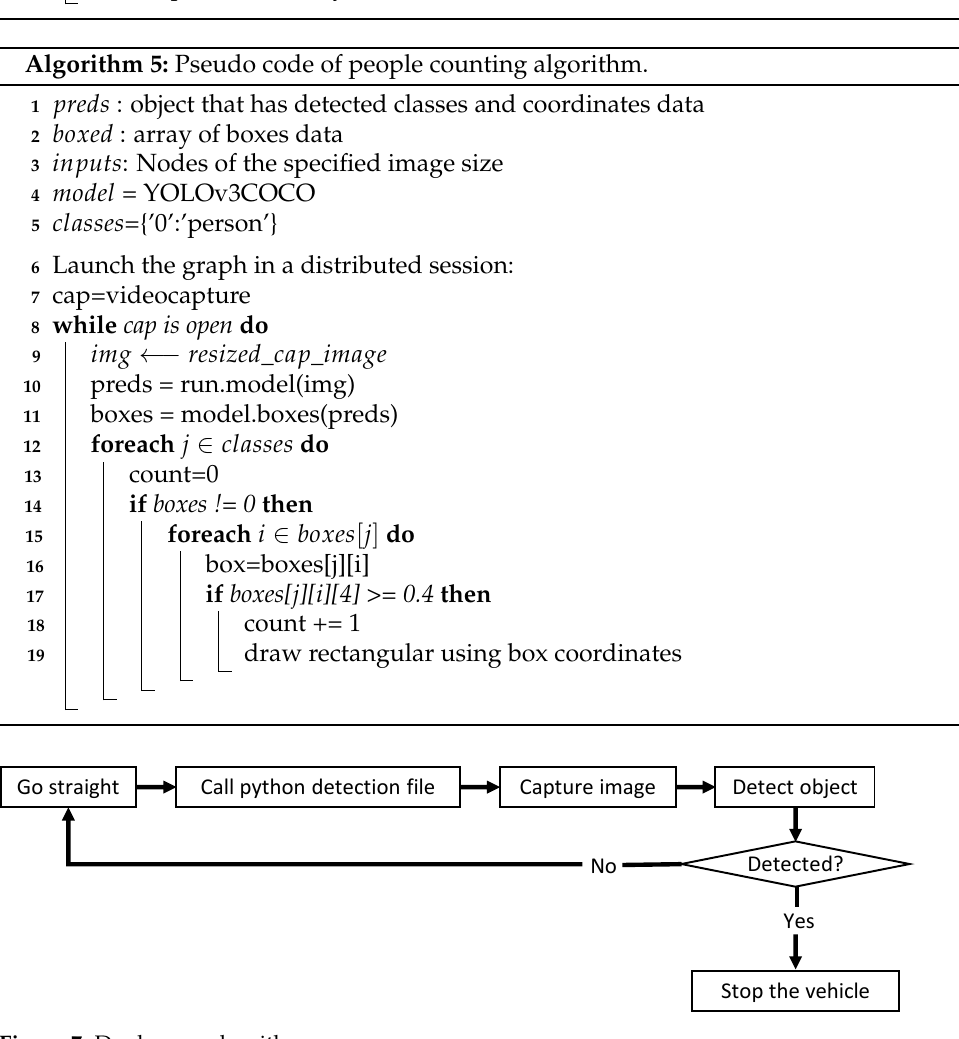
Figure 7. Donkeycar